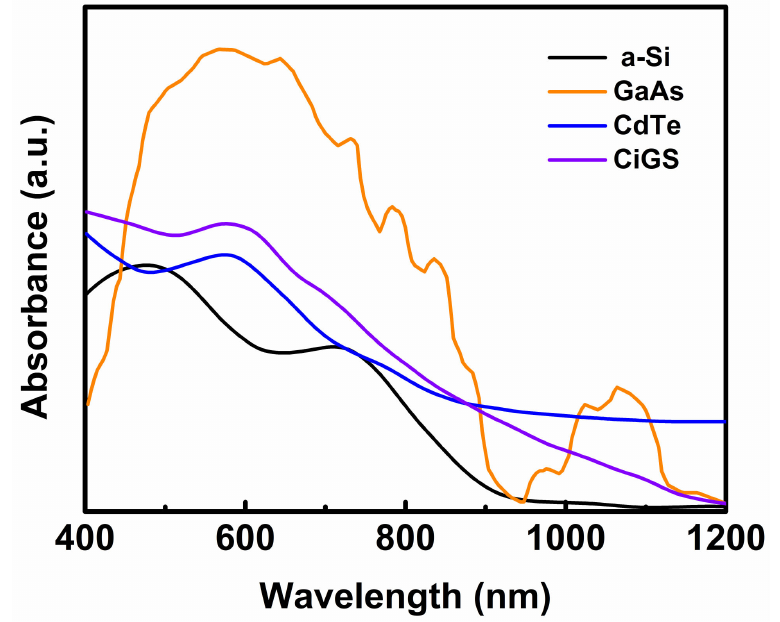
Figure 4. Absorption spectra of some widely used active materials in ISCs for indoor applications (Reproduced from [60,61], with permission from Elsevier, 2016 and AIP, 2016